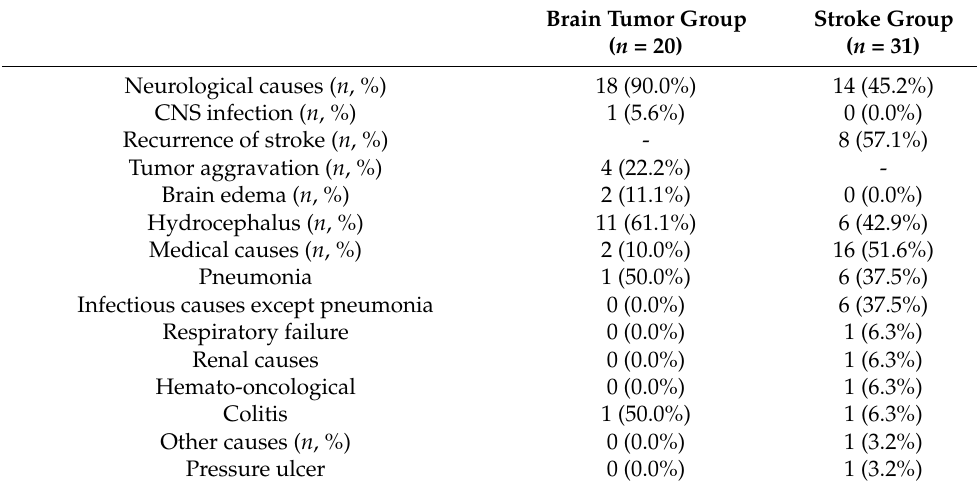
Table 2. Reasons for unplanned transfers in each group.